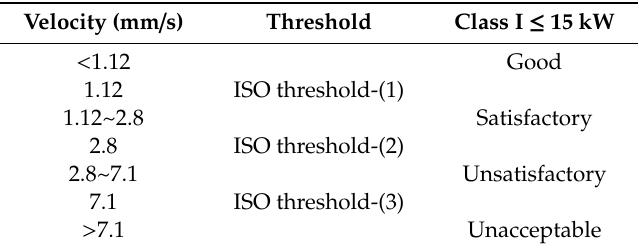
Table 2. Thresholds by Std. ISO 10816-1.